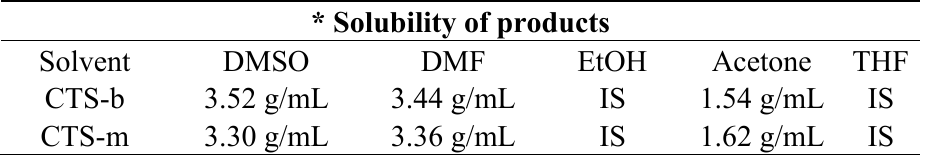
Table 2. The solubility of the benzoyl chitosans in various organic solvents.